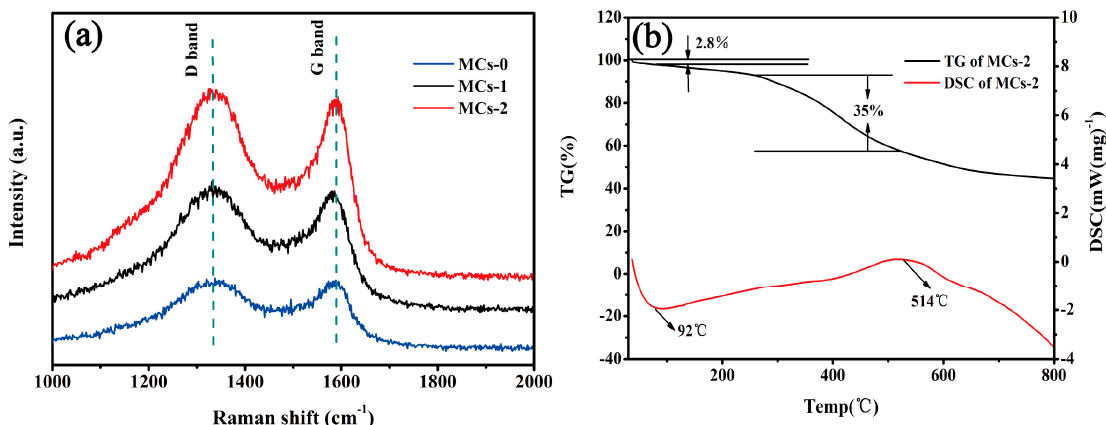
Figure 5. ( a ) Raman spectra of MCs-0, MCs-1, and MCs-2 ( b ) Thermogravimetry (TG) / Differential scanning calorimeter (DSC) curves of the MCs-2.